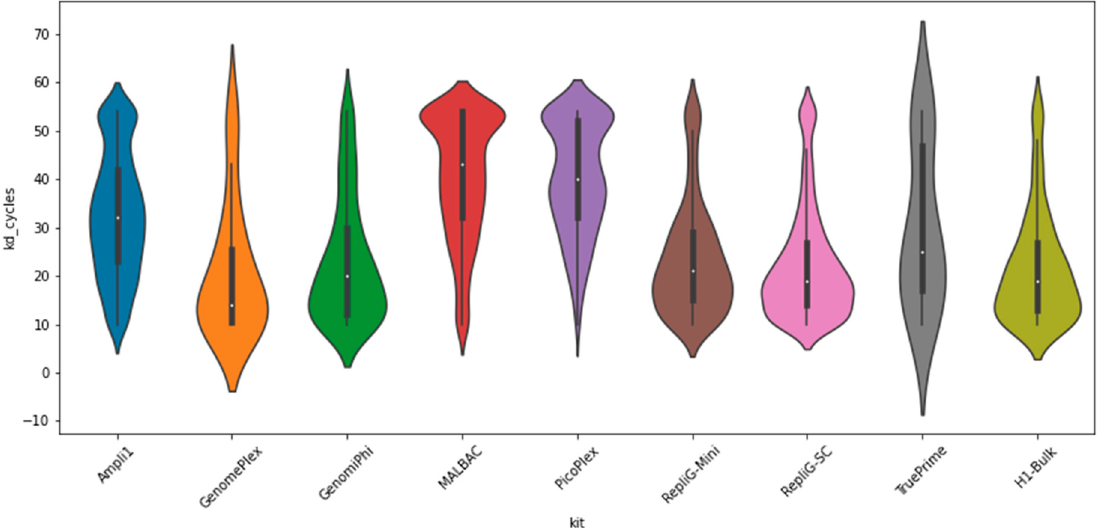
Figure 5. Amplification noise (lower is better). Amplification errors and quantification of the different single-cell WGA kits. Simulated STR stutter noise model was fitted for AC-type STR loci targets as part of the STR genotyping process [5]. The results clearly separate the MDA-based methods from the PCR-based one, which accumulates more relative stutter cycles, equivalent to up to 30 additional PCR cycles.